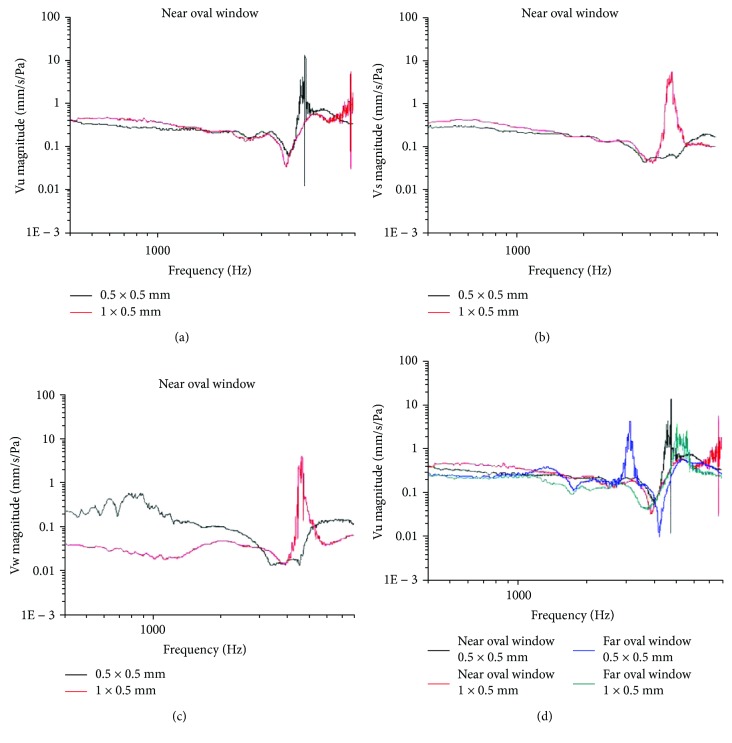
Effects of SSCD with different sizes and locations on the movement of the tympanic membrane, stapes head, and RWM by LDV measurements presurgery and postsurgery SSCD. (a) Vibration of the tympanic membrane (Vu) in the groups with different sizes of dehiscence (0.5 × 0.5 mm and 1.0 × 0.5 mm) near the oval window. Vu in the group with the larger dehiscence (1.0 × 0.5 mm; red line) was stronger than in the group with the smaller dehiscence (0.5 × 0.5 mm; black line), in the range of 500–1000 Hz (P < 0.05). (b) Vibration of the stapes head (Vs) in groups with different sizes of dehiscence (0.5 × 0.5 mm and 1.0 × 0.5 mm) near the oval window. Vs in the group with the larger dehiscence (1.0 × 0.5 mm; red line) was stronger than in the group with the smaller dehiscence (0.5 × 0.5 mm; black line), in the range of 400–1000 Hz (P < 0.05). (c) Vibration of the round window (Vw) in groups with different sizes of dehiscence (0.5 × 0.5 mm and 1.0 × 0.5 mm) near the oval window. Vw in the group with the larger dehiscence (1.0 × 0.5 mm; red line) was weaker than in the group with the smaller dehiscence (0.5 × 0.5 mm; black line), in the range of 400–2000 Hz (P < 0.001). (d) Vibration of the tympanic membrane in the groups with different sizes of dehiscence located at different points (n = 6 in each group). Vibration in the group with the larger dehiscence (1.0 × 0.5 mm; red line) was stronger than in the group with the smaller dehiscence (0.5 × 0.5 mm; black line) near the oval window (P < 0.05) in the range of 500–1000 Hz. Vibration in the group with the smaller dehiscence (0.5 × 0.5 mm; black line) near the oval window was stronger than in the groups with larger (green line) or small dehiscences (blue line) far from the oval window (P < 0.05) in the range of 400–800 Hz. There were no statistically significant differences between the groups with different sized dehiscences away from the oval window (P > 0.05).